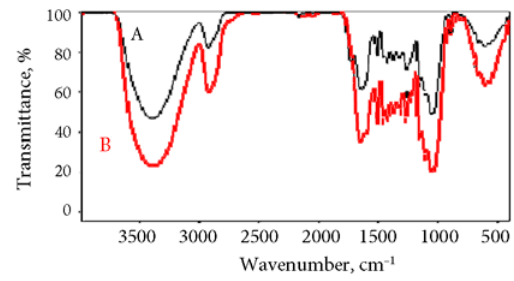
Fig. 7. FTIR of untreated peanut husk (A) and chemically treated peanut husk